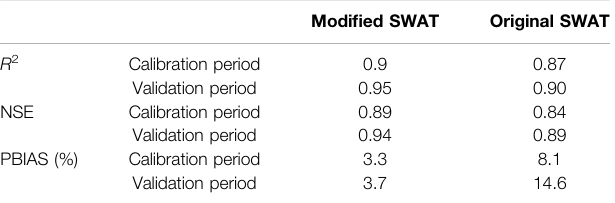
TABLE 1 | The performance of the original and modi fi ed Soil and Water Assessment Tool (SWAT) models in simulating the monthly stream fl ow.